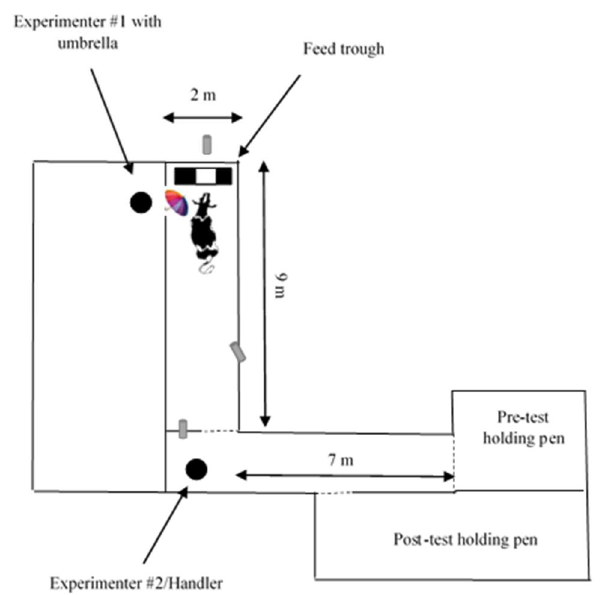
Figure 3. Diagrammatic representation of the startle response test. The walls of the startle response test arena were blackened out to a height of 2.7 m. Three cameras recorded behavioural response from above the test arena at locations indicated by grey cylinders.